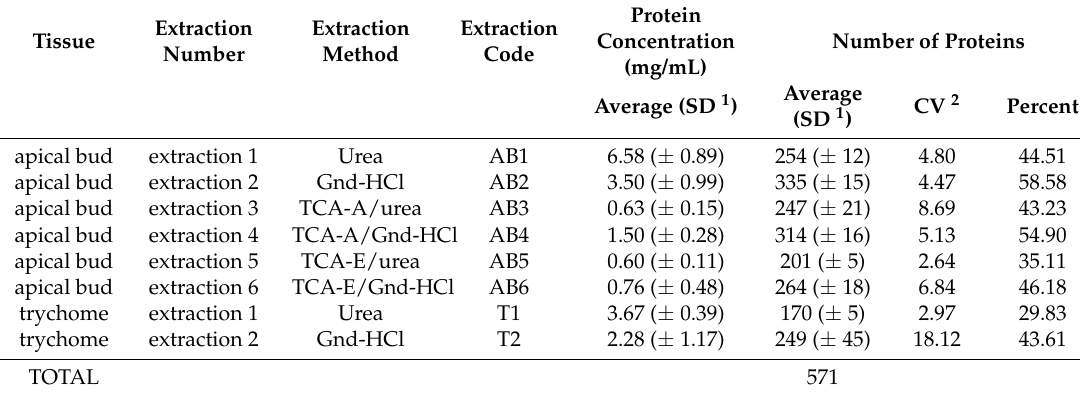
Table 1. Protein extraction efficiency of the six methods tested on cannabis apical buds and trichomes assessed by top-down